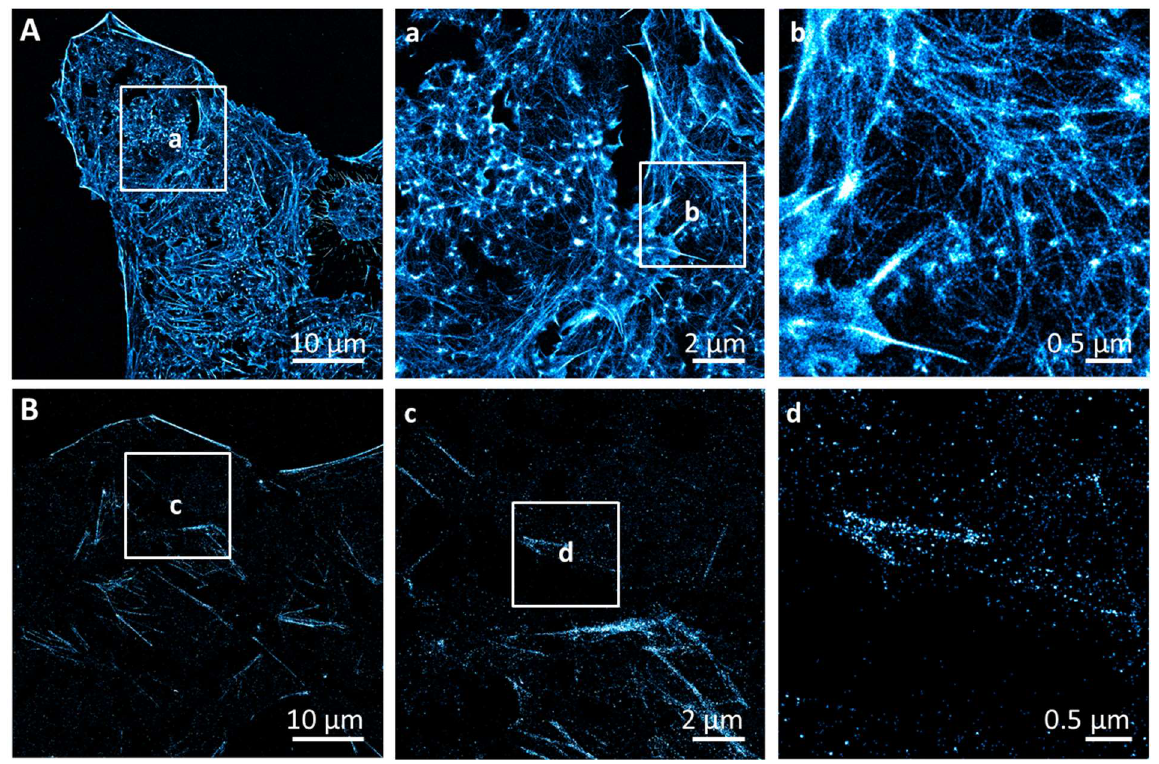
Figure A4. STORM imaging of U2OS cells, showing the effect of actin depolymerization. ( A ) U2OS untreated control cells were fixed with 3.7% PFA, stained with Alexa Fluor™ 647 Phalloidin (#A22287), and imaged in a standard STORM imaging buffer with 100mM MEA, as previously described [50,51]. Magnifications ( a , b ) show intact F-actin fibers. ( B ) U2OS cells treated with 2 μM LA for 10 min stained with Alexa Fluor™ 647 Phalloidin and imaged with STORM. Magnifications ( c , d ) clearly show a significant reduction in large fibers that are characteristic of depolymerization of the actin cytoskeleton. The experiment was performed twice with similar results (N = 2), and included three cells for each condition.